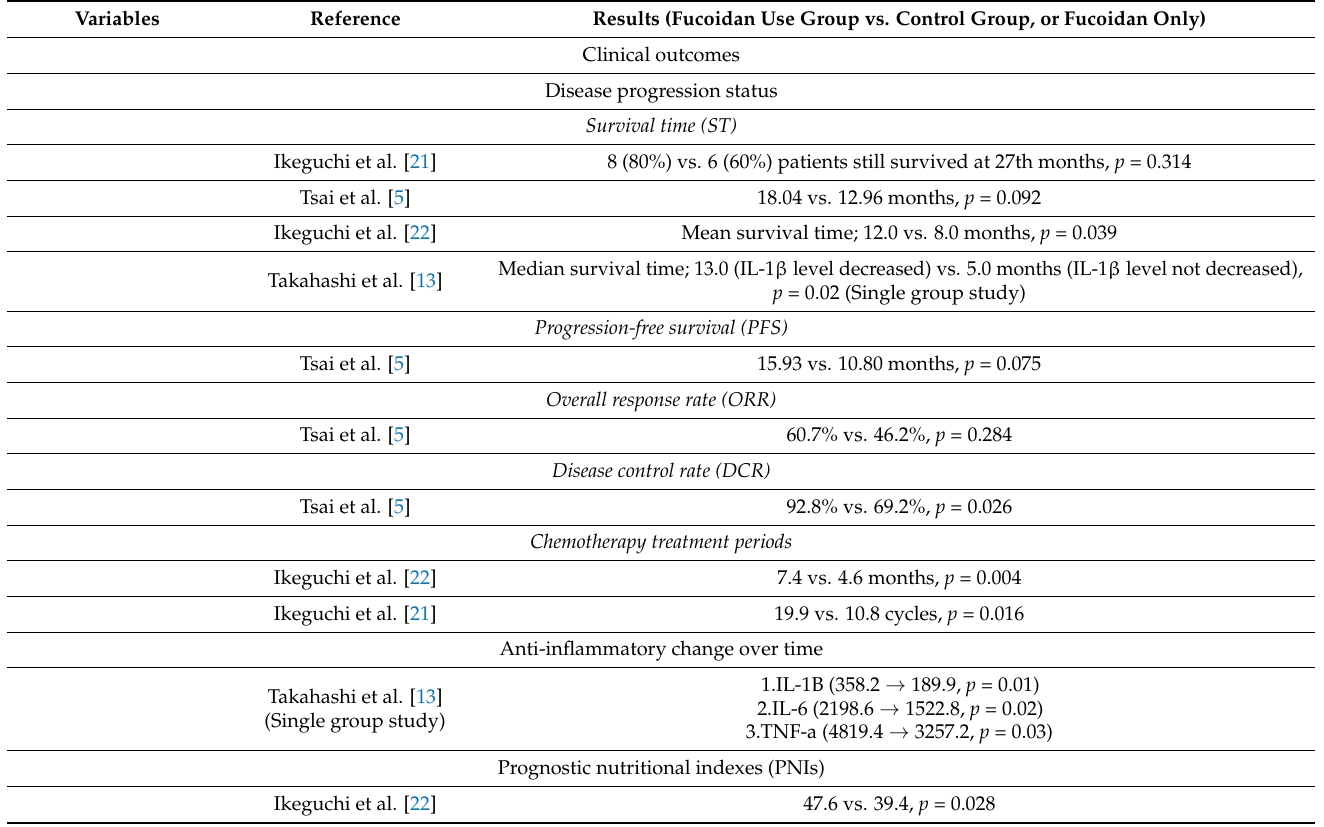
Table 2. Importantoutcomesandresultsofincludedstudies—clinicaloutcomesandpatient-reported